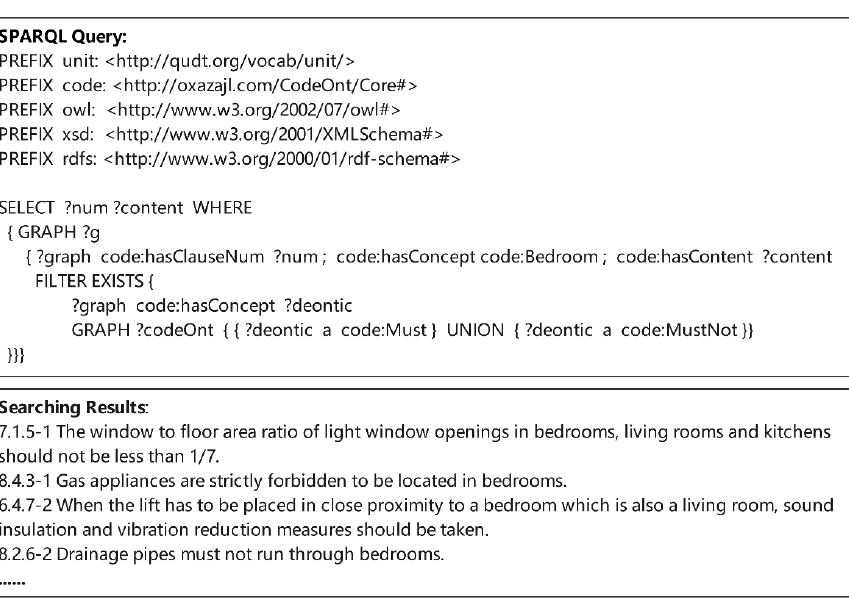
Figure 19. SPARQL query to retrieve the recommended clauses for clause